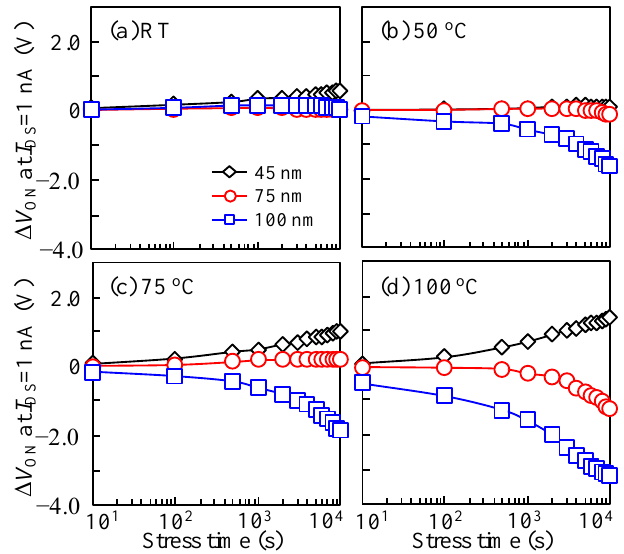
Figure 5. Variation in the ∆ V ON with DCS duration for the TFT devices measured at test temperatures of ( a ) RT, ( b ) 50, ( c ) 75, and ( d ) 100 °C.